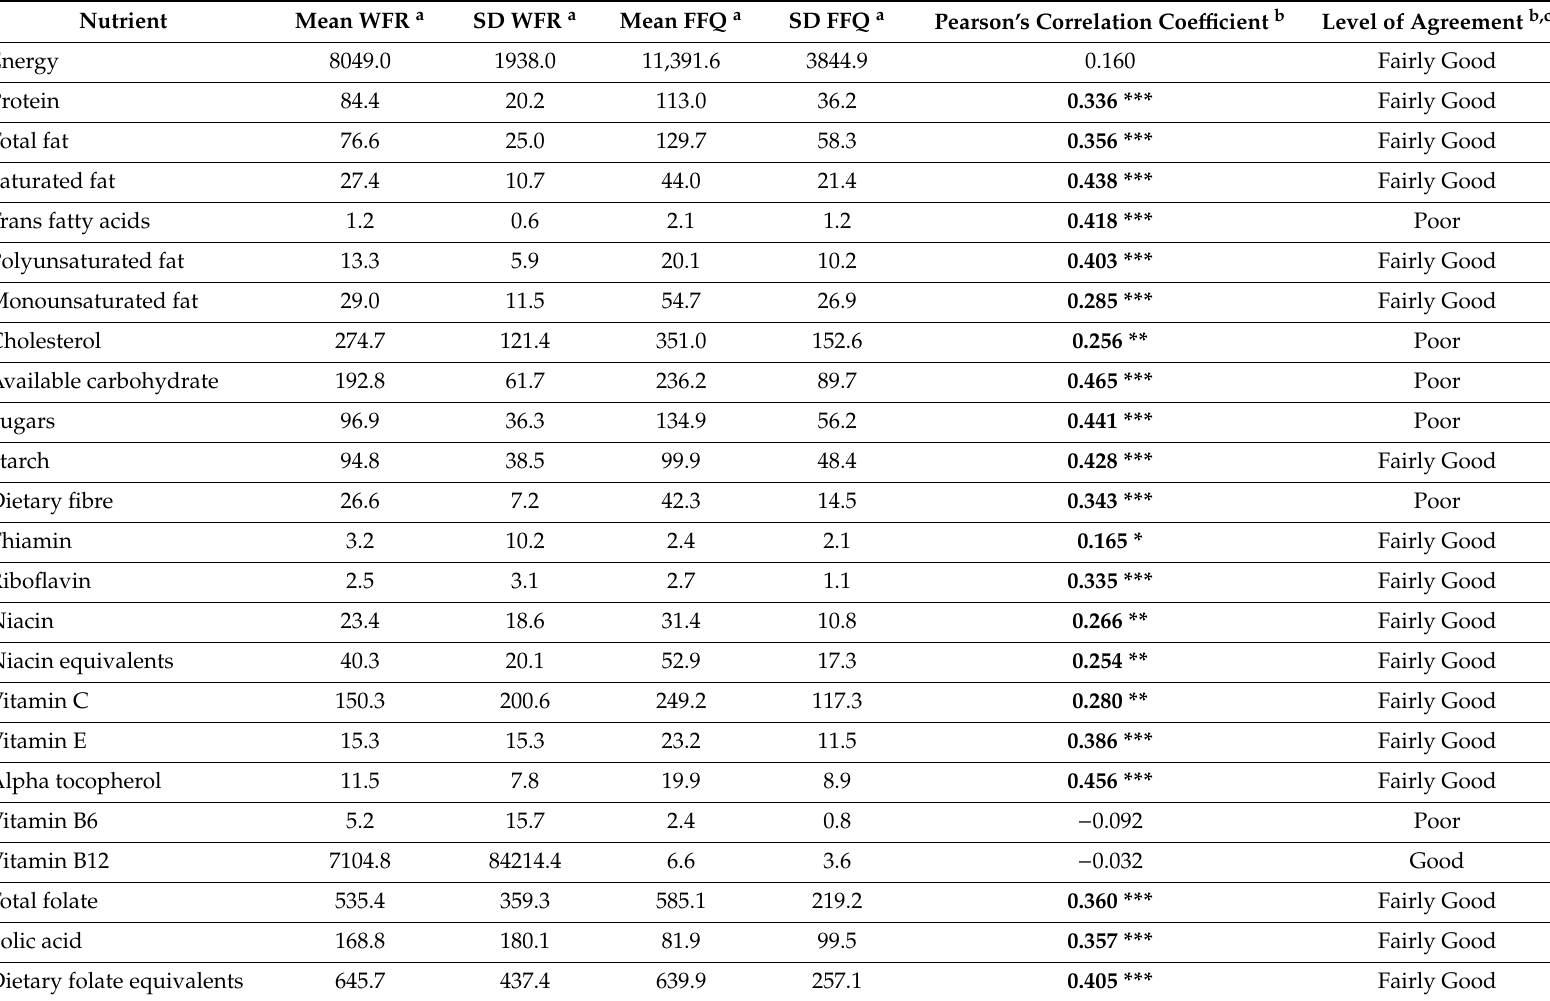
Table 2. Associations between energy and nutrient intakes obtained from the Alzheimer’s disease-CSIRO Food Frequency Questionnaire and four-day weighed food